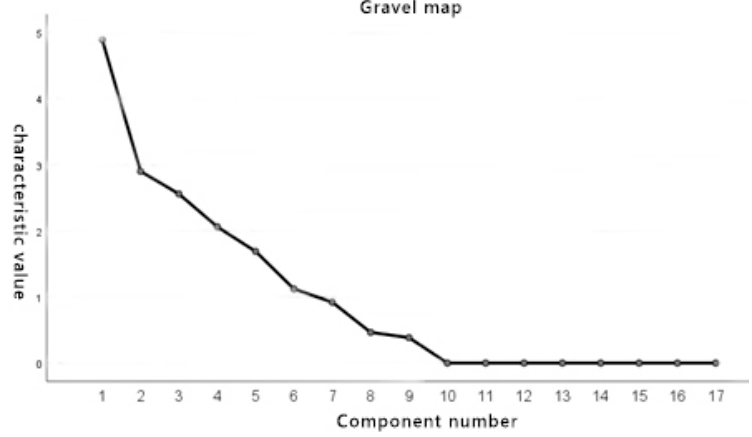
Figure 5. Scree plot of extraction of antigenic factor components.